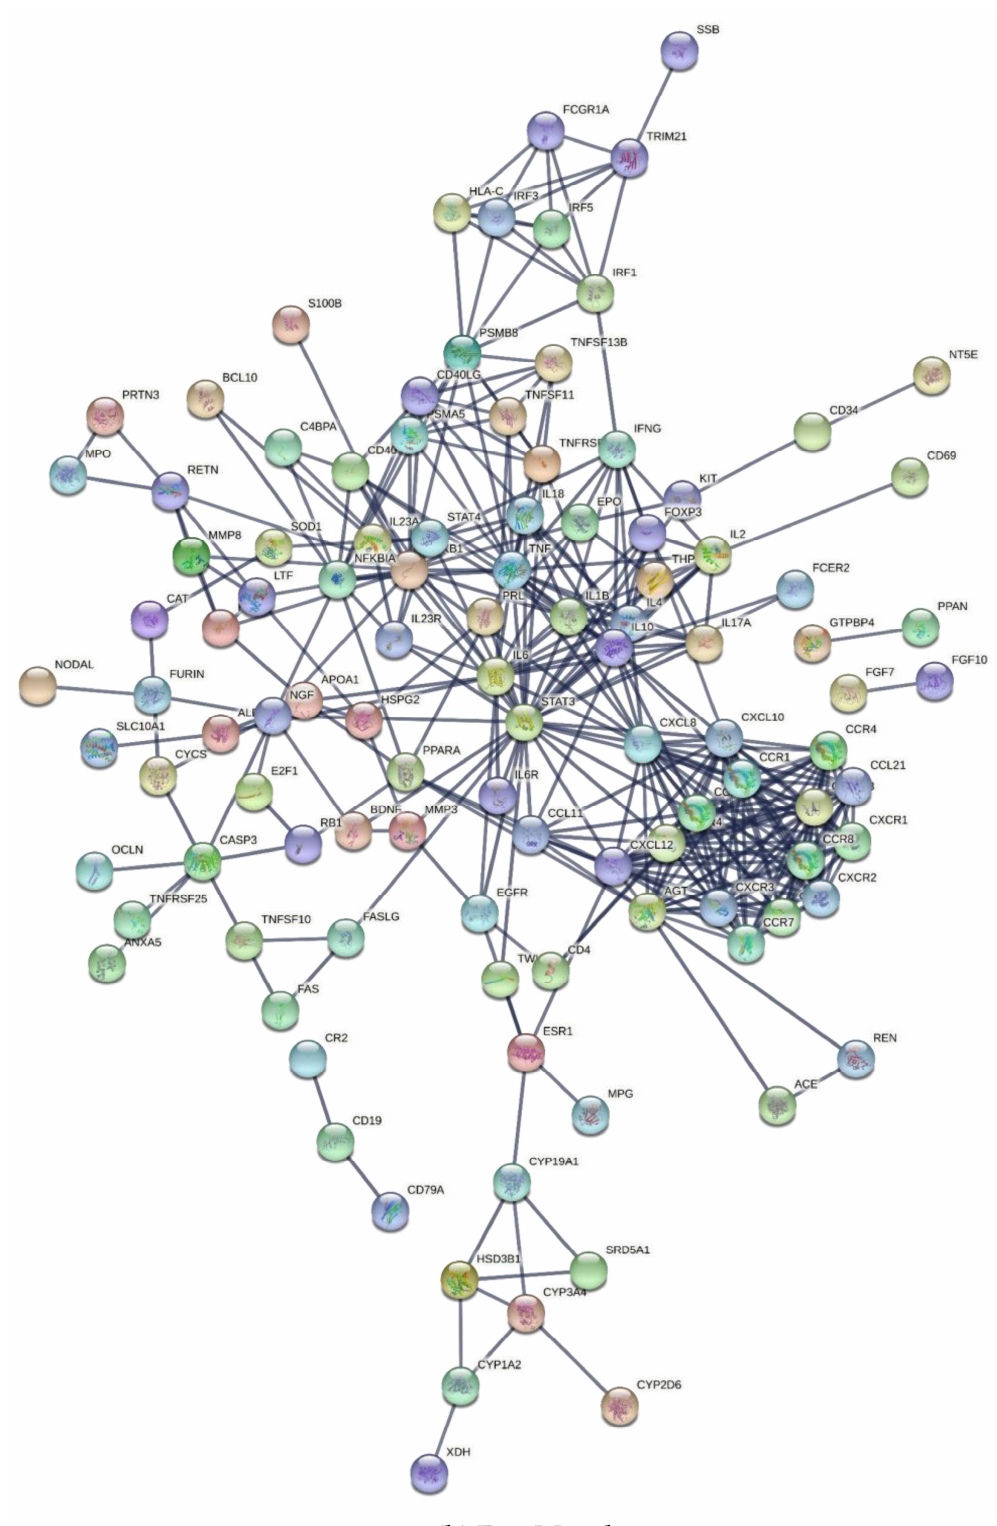
Figure 2. STRING PPI Networks for Xerostomia and Dry Mouth. STRINGv11.0 protein–protein interaction networks for genes identified using search terms combined with ( a ) xerostomia (input = 309 genes; output = 229) and ( b ) dry mouth (input = 159 genes; output = 110) at a confidence level of 0.90.